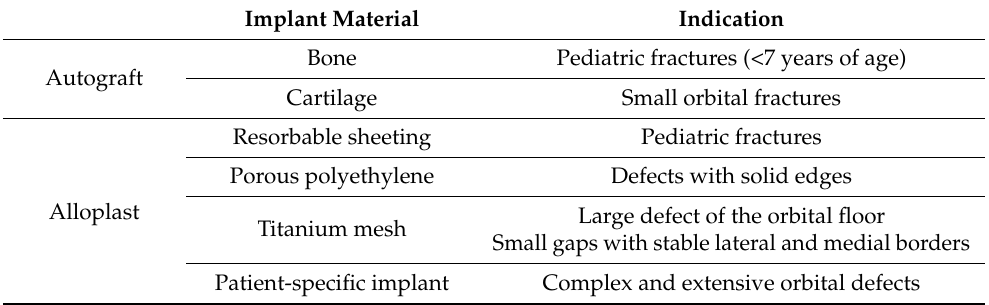
Table 1. Implant material indications